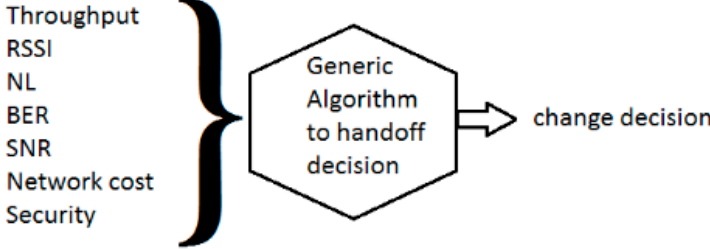
Figure 1. Generic algorithm to the handover making decision.